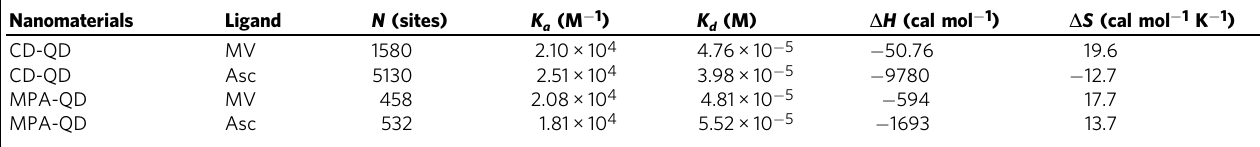
Thermodynamic parameters including number of binding sites ( N ), association constant ( Ka ), dissociation constant ( Kd ), enthalpy change ( Δ H ), and entropy change ( Δ S ) of interactions between QD (CD-QD or control MPA-QD) and chemical cargoes (methyl viologen or ascorbic acid).